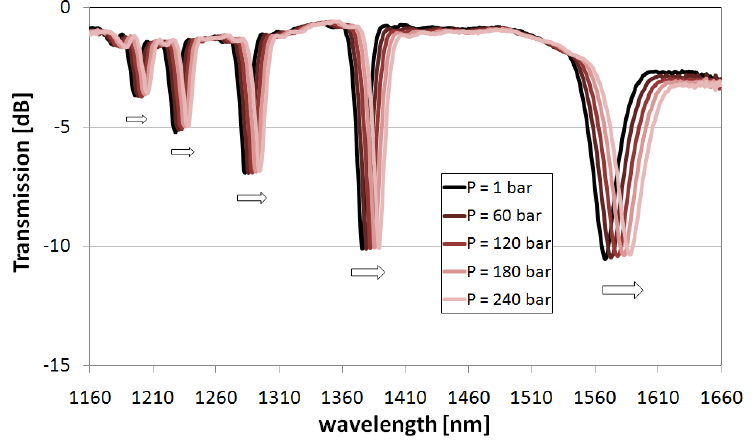
Figure 3. Spectral response of SiN coated (thickness 28.5 nm and n = 2.293) LPGs to x pressure ranging from 1 to 240 bars. Arrows show the direction of the shift of the resonances induced by the increase of pressure. The measurements were performed in oil (n = D